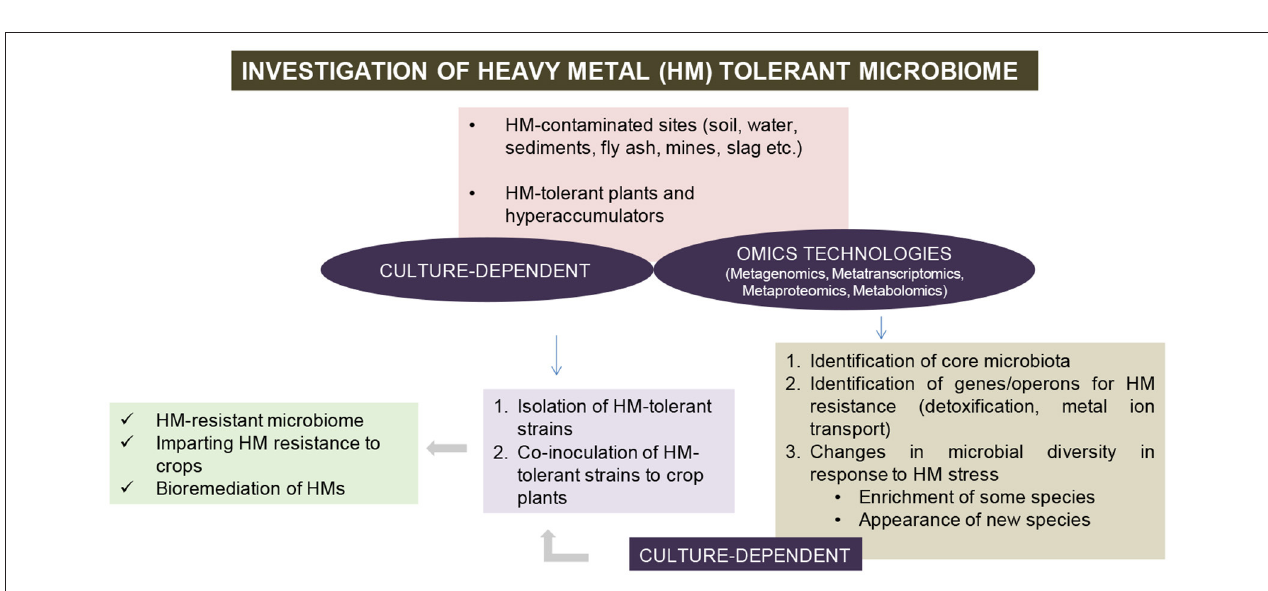
FIGURE 2 | Strategies for investigation of HM-tolerant (HMT) microbiome.